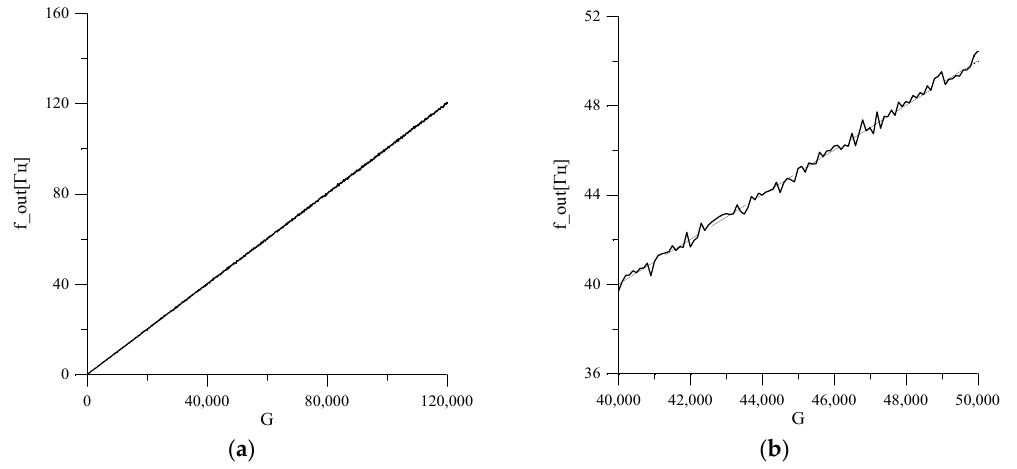
Rg5: G , 0, 0, 0, 0, correspondingly. 1000 Δ = G . A decrease in value Δ G for 6 = q , led to some ambiguity in establishing the aver-